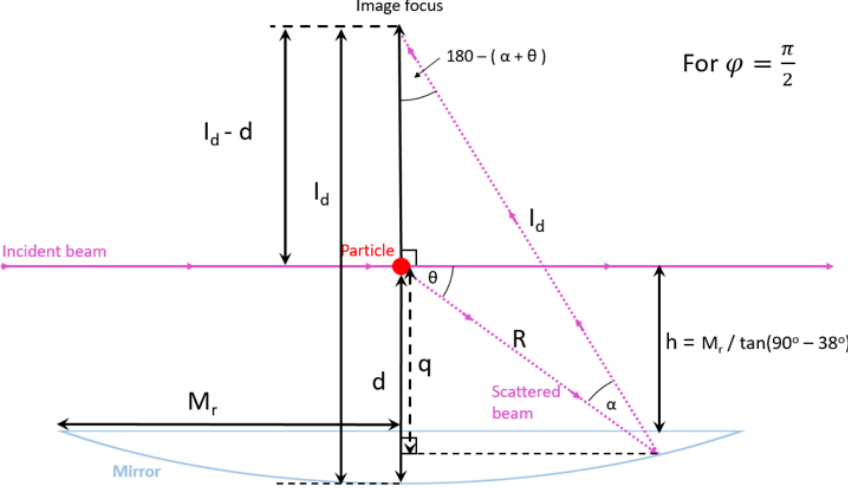
Figure A1. Geometry of POPS optical chamber. Values for the fixed parameters are listed in Table A1.